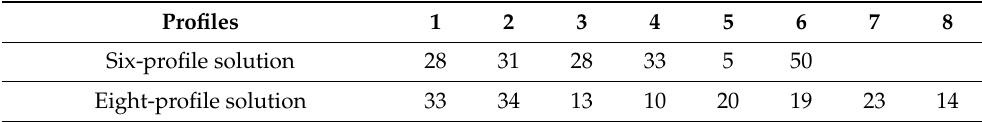
Table 4. Profile sizes of the six- and eight-profile solutions.